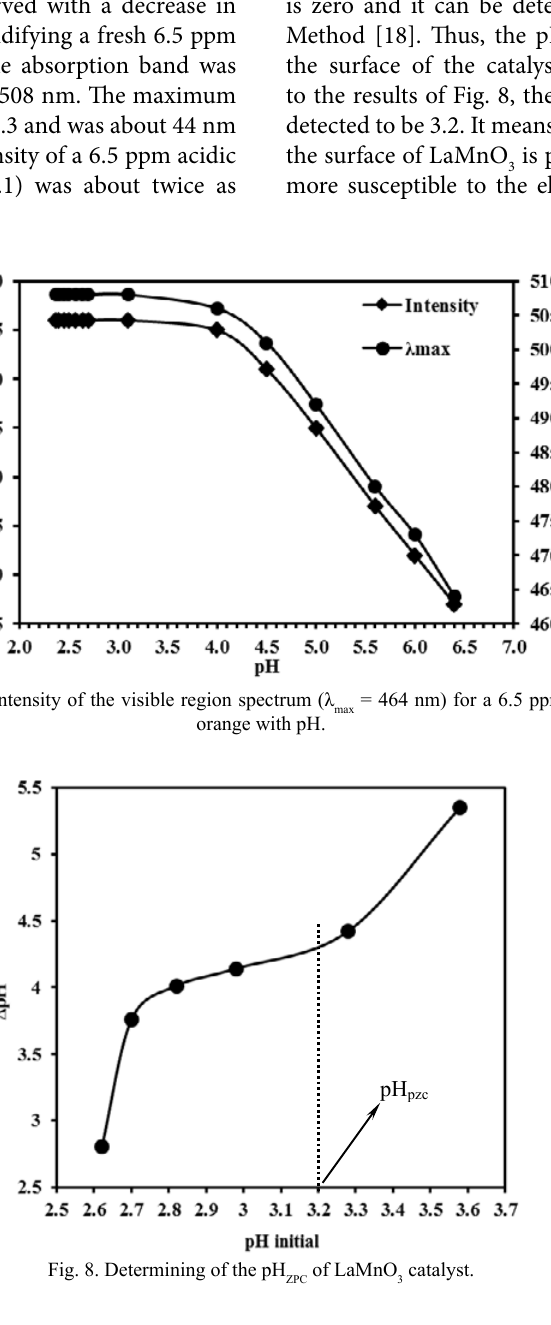
Fig. 8. Determining of the pH